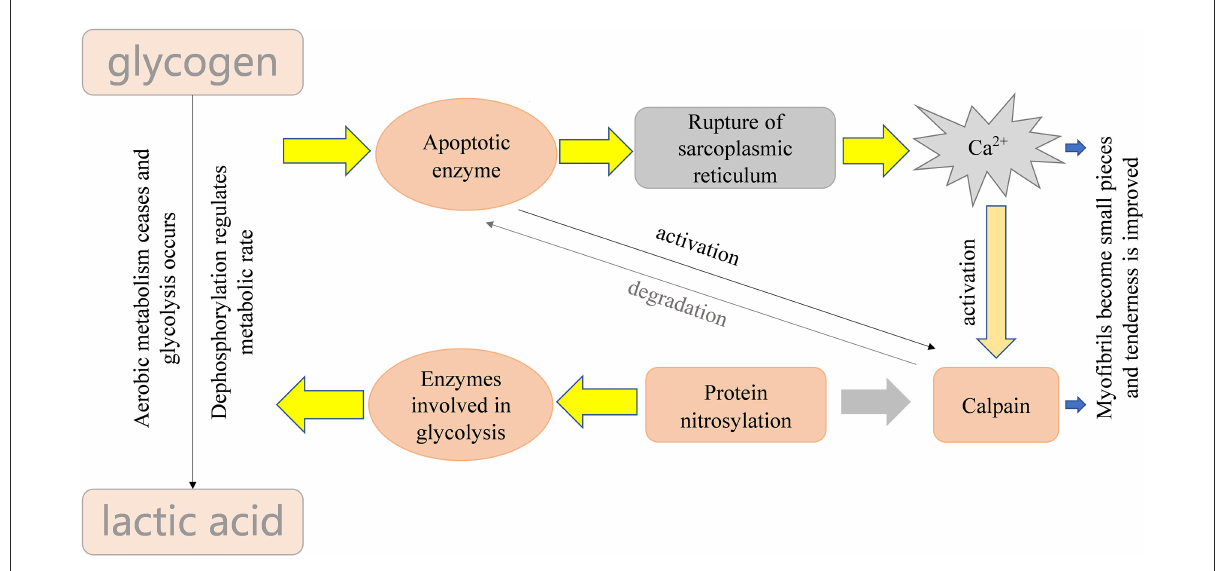
FIGURE1 Integrated multiple mechanisms for postmortem aging of